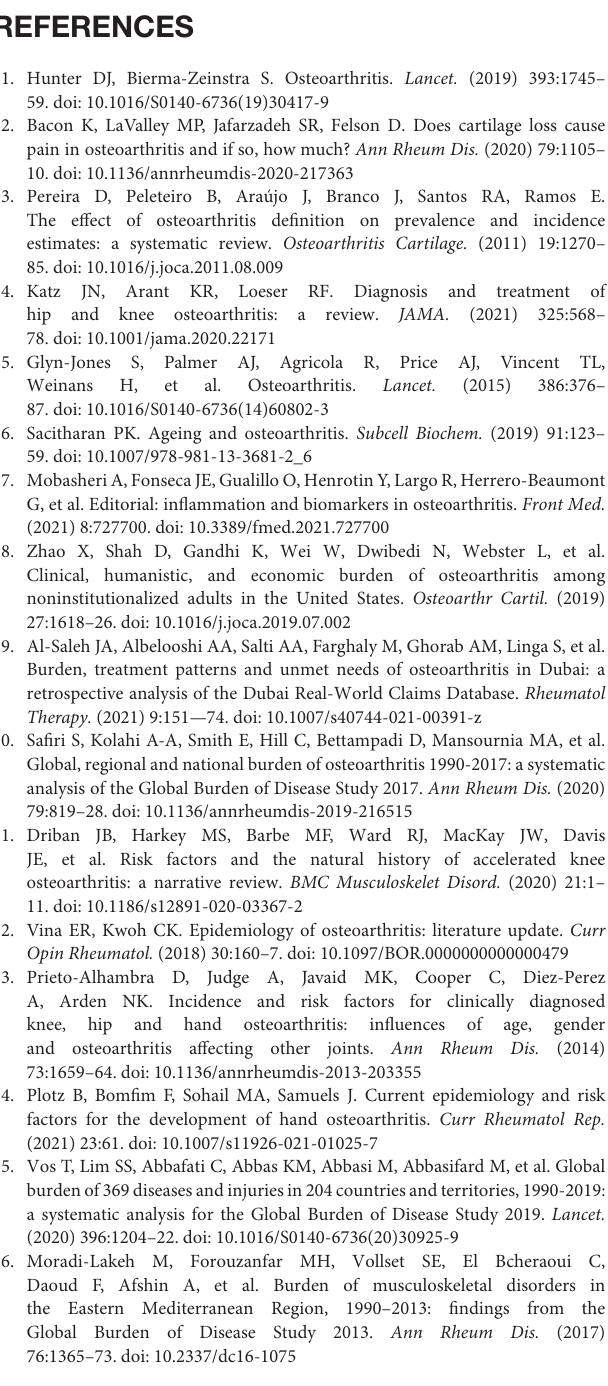
Supplementary Figure S10 | Number of YLDs and YLD rate for osteoarthritis per 100,000 population in the Middle East and North Africa region, by age and cause in 2019. YLD = years lived with disability (generated from data available from http://ghdx.healthdata.org/gbd-results-tool). Supplementary Table S1 | Prevalence of osteoarthritis in 1990 and 2019 for both sexes and percentage change in age-standardized rates (ASRs) per 100,000 in the North Africa and the Middle East region (generated from data available from http://ghdx.healthdata.org/gbd-results-tool).